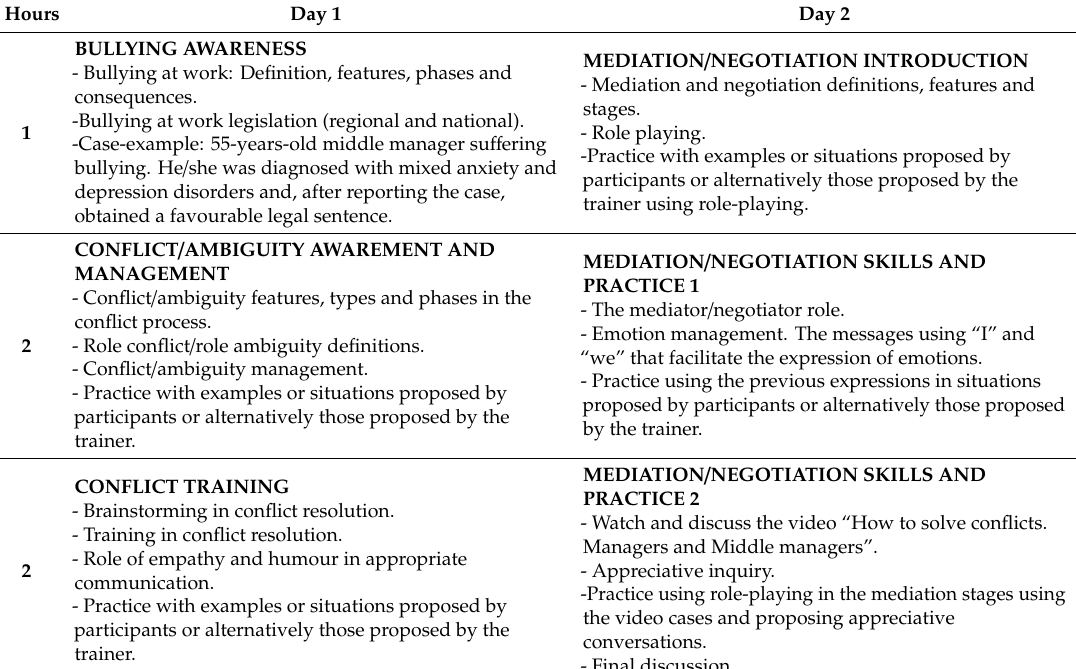
Table A1. Bullying at Work